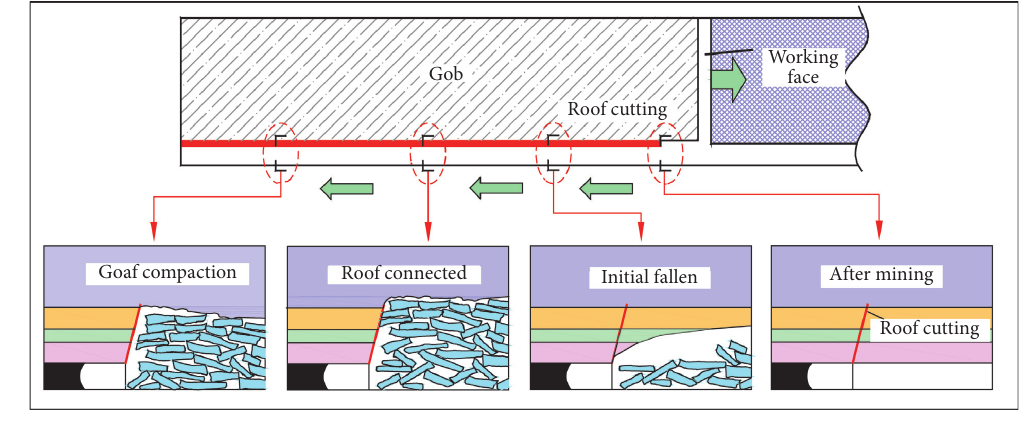
Figure 4: Falling and compacting of the